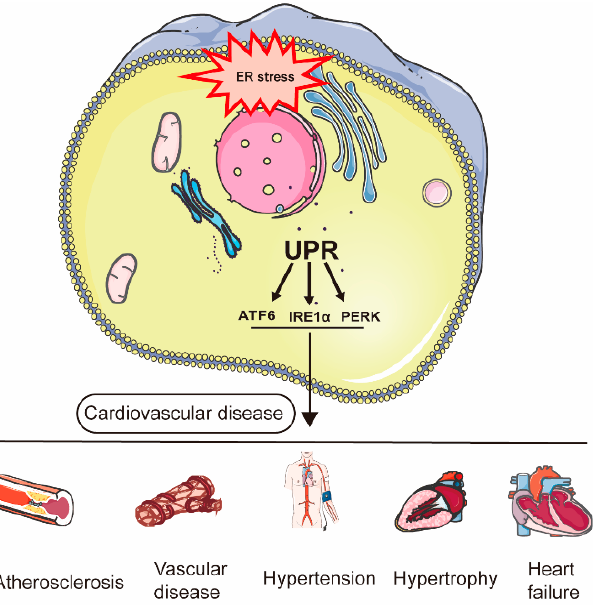
Figure 1. The mechanism of ER stress and UPR in cardiovascular disease. ER stress: endoplasmic reticulum stress; UPR: unfolded protein response. IRE1a: inositol-requiring kinase 1; ATF6: activating transcription factor 6; PERK: protein kinase-like ER kinase.